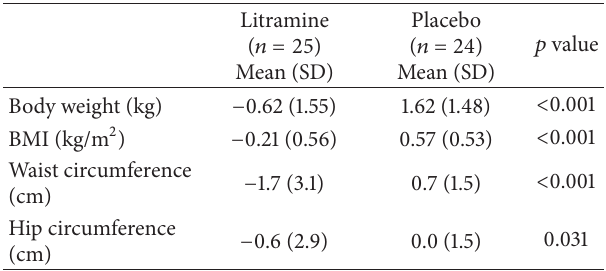
Table 2: Mean changes in primary and secondary parameters between baseline and week 24.